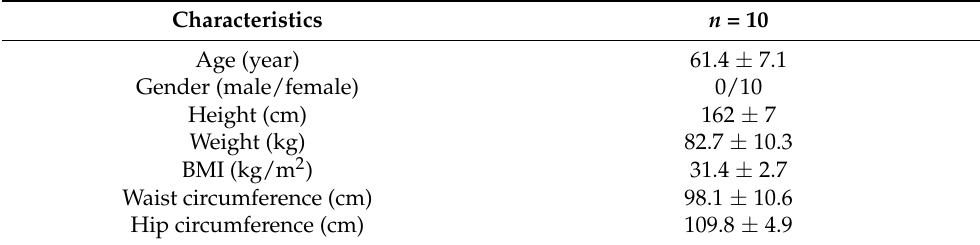
Table 1. Baseline characteristics of the study